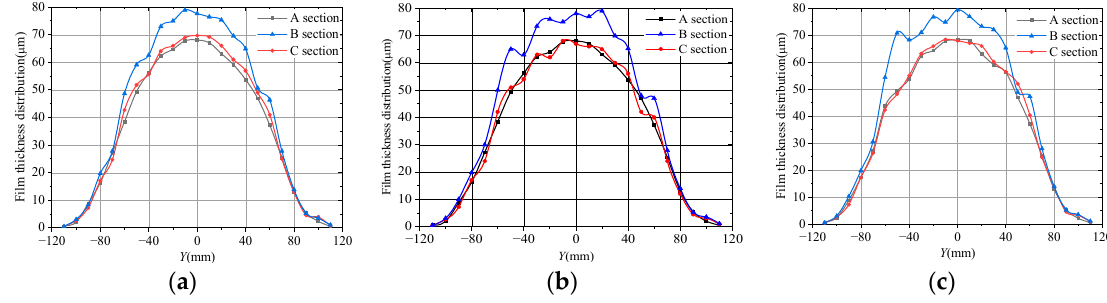
Figure 7. Film thickness distributions on different sections of arc connecting surfaces with different angles. ( a ) 60 degrees; ( b ) 90 degrees; ( c ) 120 degrees.